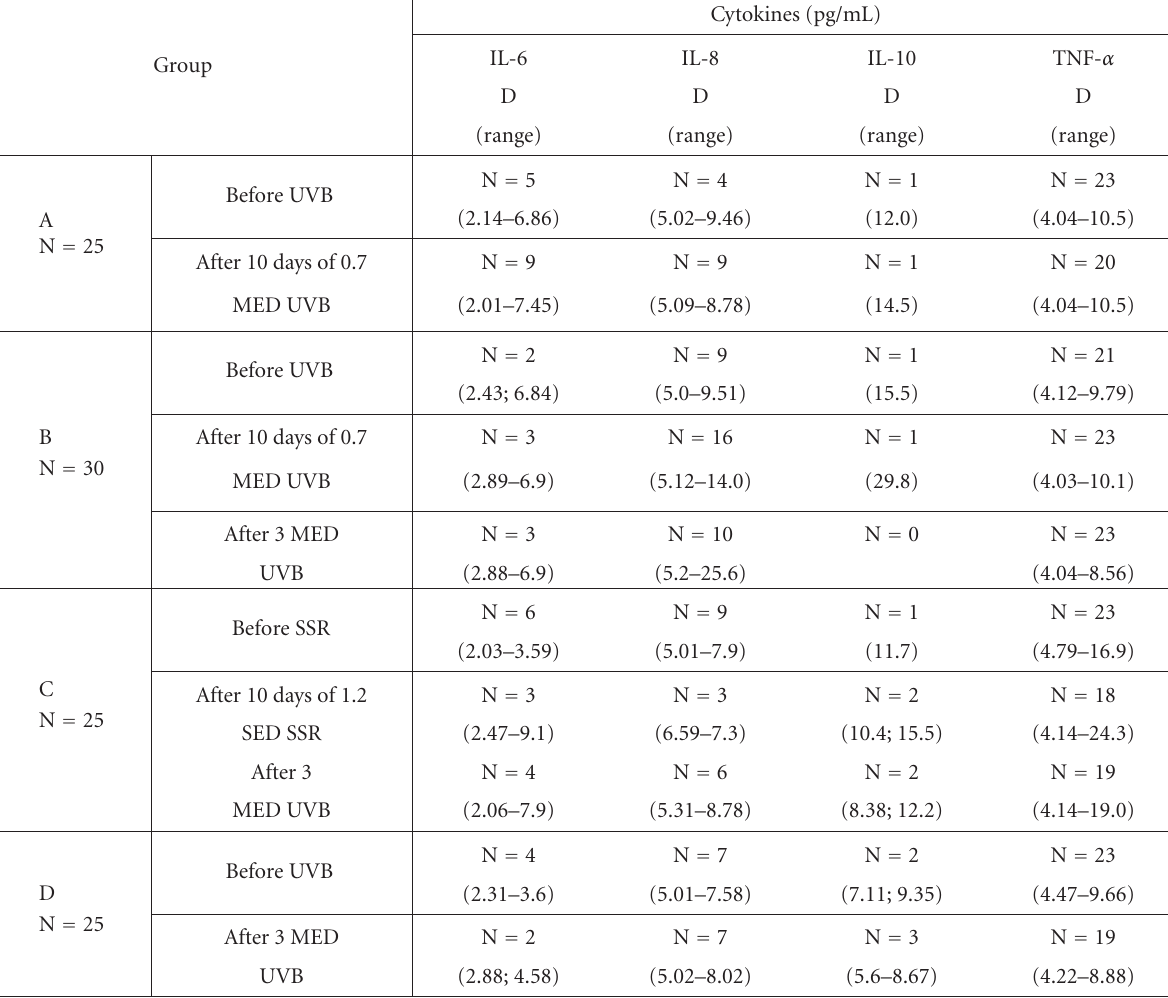
Table 2. Serum concentrations of selected cytokines in all examined groups. N is the number of volunteers, D detectable level, MED minimal erythema dose, UVB ultraviolet radiation B, and SSR solar-simulated radiation. Cytokines (pg/mL) IL-6 IL-8 Group (range) (range) (range)